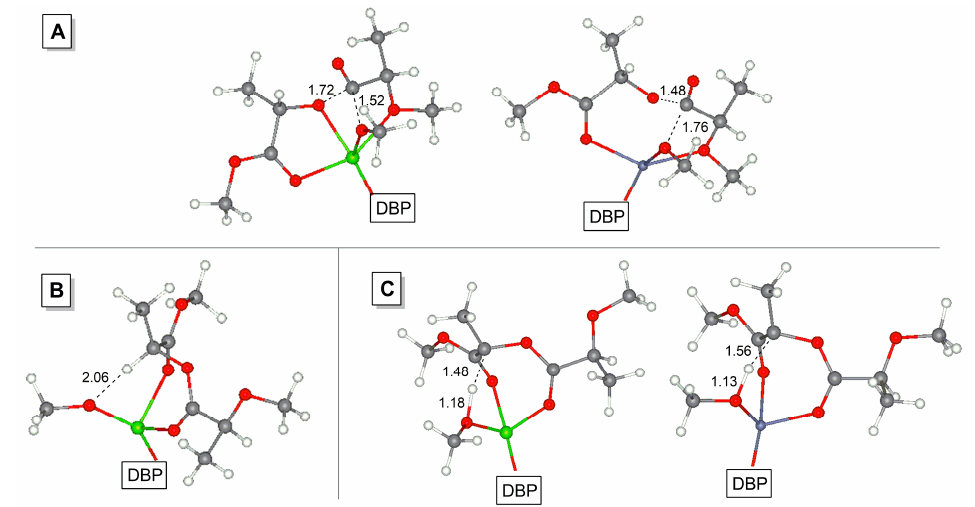
Figure 5. Optimized geometries of the transition states of PLA transesterification TS-1 ( A ) and enolization TS-3 ( C ) for M = Mg (left) and Zn (right); close contact in Mg-MOMP complex I-3’ ( B ). Interatomic distances are given in Å.